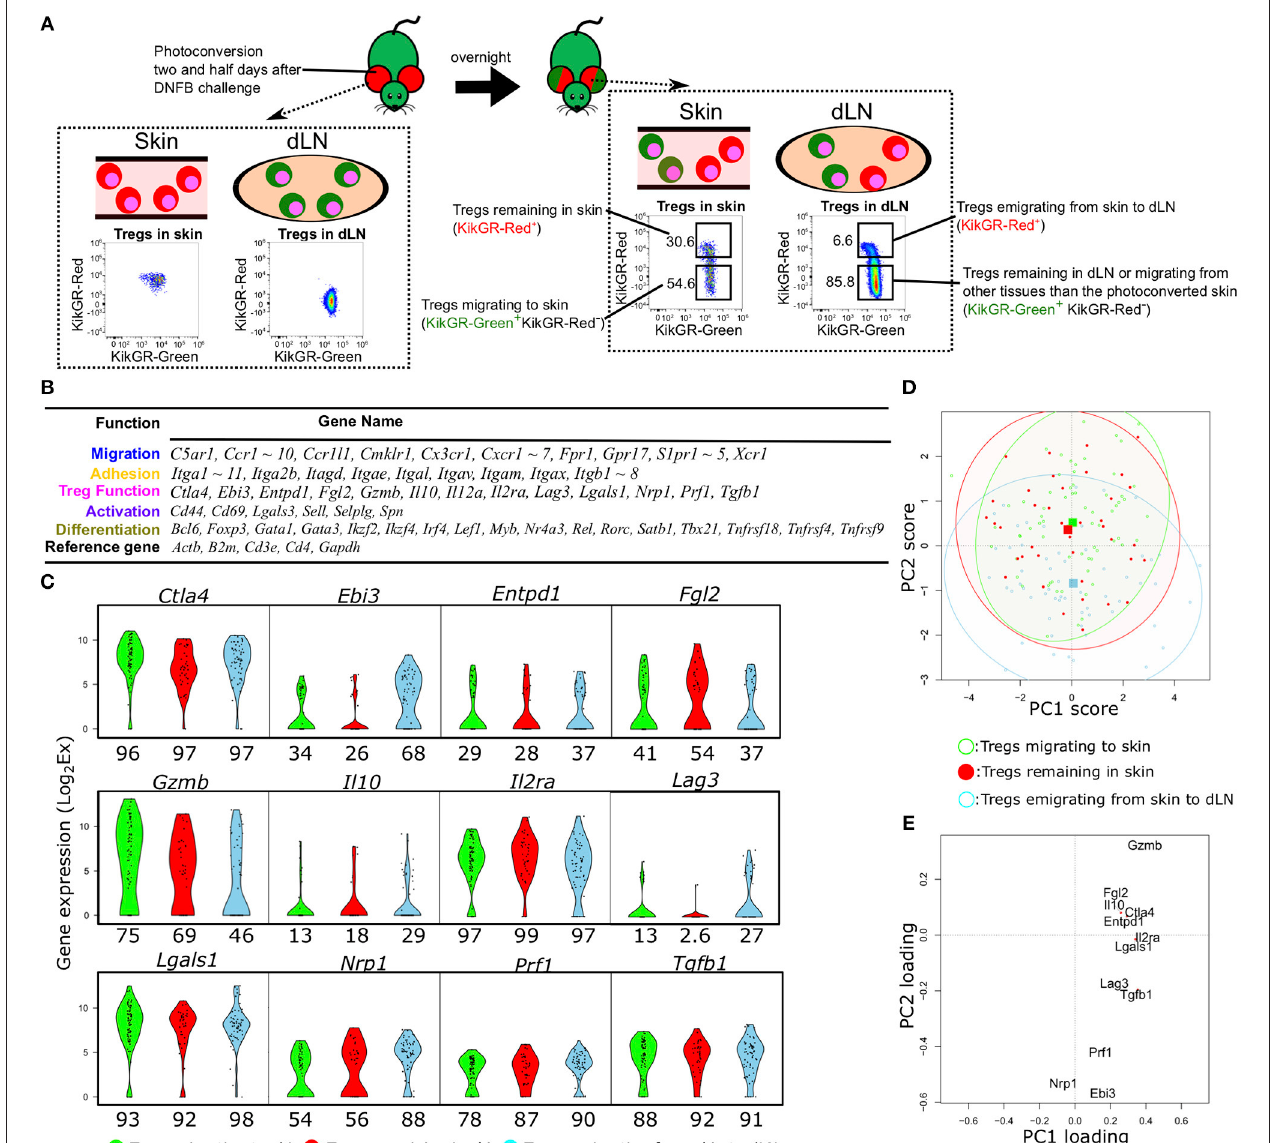
FIGURE 1 | Single-cell qPCR analysis of Tregs migrating to, remaining in, or emigrating from CHS-induced inflamed skin. (A) Experimental scheme for discrimination of Tregs migrating to, remaining in, emigrating from the inflamed skin and FCM gating for KikGR-Green + (KikGR-Red − ) or KikGR-Red + cells. Values in plots indicate the percentage of the parent population. Data are representative of four independent experiments with two mice per group. (B) Genes measured by scqPCR. Genes are grouped by their representative function. (C) Violin plots showing expression levels of genes related with Treg function. Percentages under each plot indicate the proportion of cells that expressed the gene. (D) Principal component (PC) projections of individual Tregs within the three migratory populations. PC2 and PC3 are shown (accounting for 12.5 and 10.4% of the total variation, respectively). The confidence ellipses help to visually compare relationships among the populations. Squares indicate the mean value for each subset with the same color. (E) PC projection of 12 genes, showing contributions to PC1 and PC2.